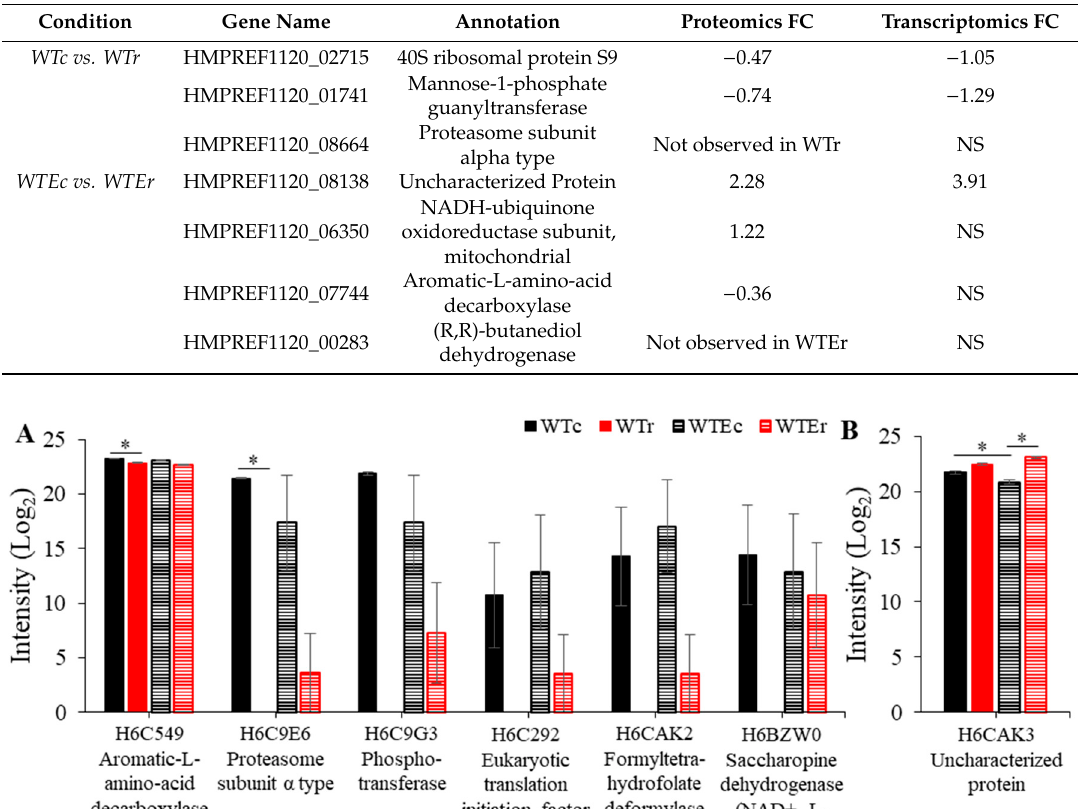
Table 1. List of proteins found in significantly di ff erent relative amounts after irradiation in WT and Evolved (WTE) strains, along with their predicted functions and the Log 2 Fold Change (FC) values for the given comparison in both the current proteomic experiment and our prior transcriptomic experiment [9]. NS = not significant. Not observed = protein was not observed in the specified sample so a fold change in relative amount cannot be calculated.